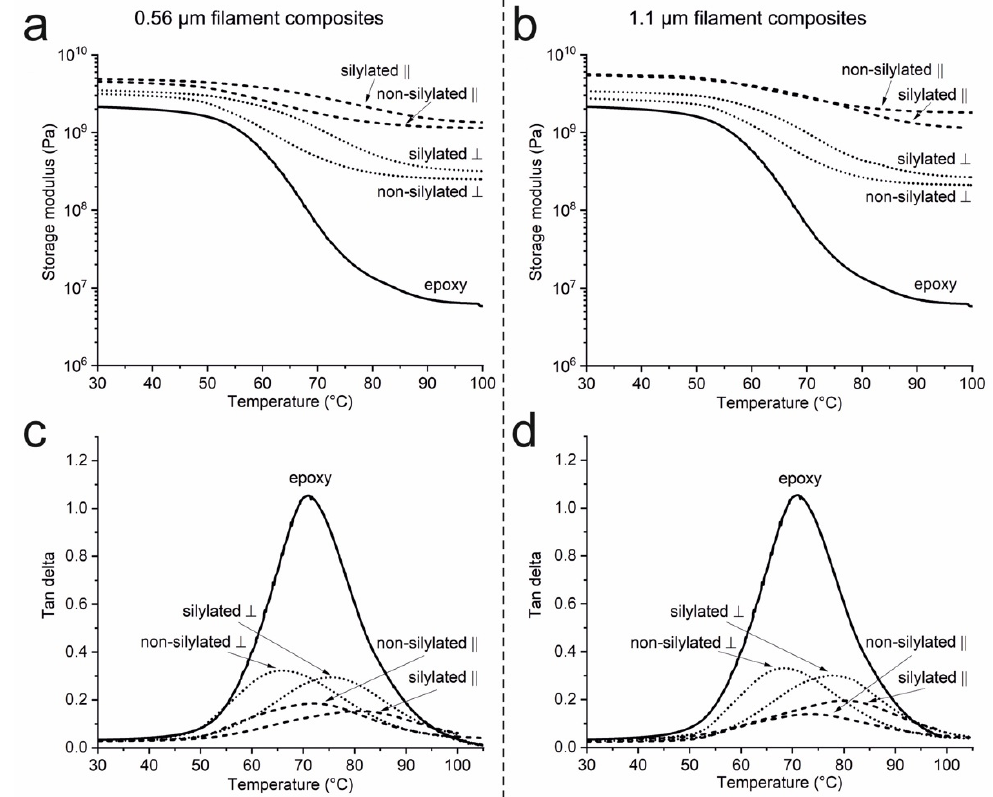
Figure 8. Viscoelastic properties of the CNF filament/epoxy composites. Storage modulus of the ( a ) 0.56 and ( b ) 1.1 µm filament composites. Tan delta of the ( c ) 0.56 and ( d ) 1.1 µm filament composites. Longitudinal ( ‖ ) and transverse ( ┴ ) specimens were prepared from the composite samples.